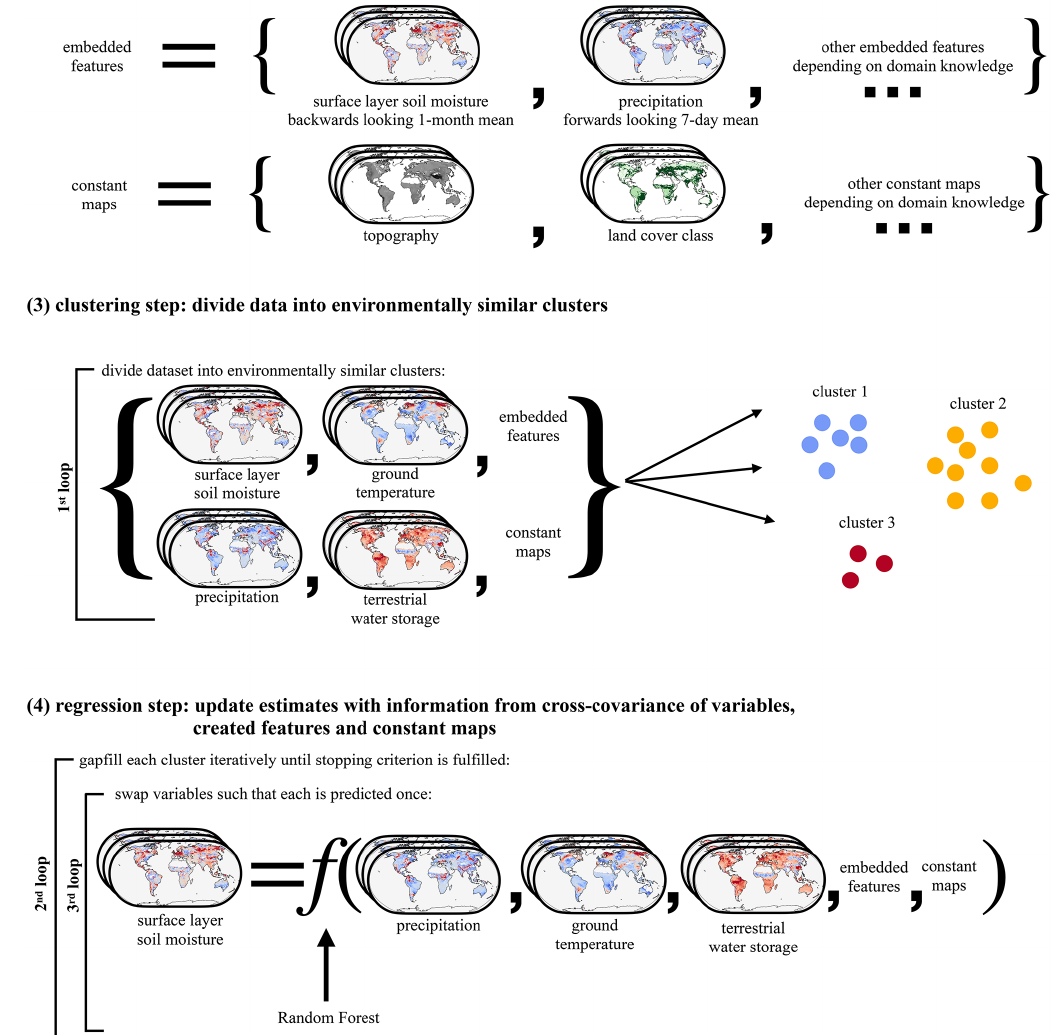
Figure 2. Overview of the structure of the gap-filling framework. The framework is divided into four steps. In the first step (Sect. 2.1), any missing value is gap filled by an initial estimate from the spatiotemporal context. This step is called interpolation step. Here the spatiotemporal mean of observed values surrounding the missing value is used for each variable individually. In the second step (Sect. 2.2), embedded features are created to inform about time-dependent processes. In the third step, the data are divided into environmentally similar clusters (Sect. 2.3, Algorithm 1). In the fourth step (Sect. 2.4, Algorithm 1), the initial estimates from step 1 are updated while accounting for the dependence structure among all considered variables. This is achieved by first grouping available data points into environmentally similar clusters and then iteratively updating the initial estimates using a supervised learning